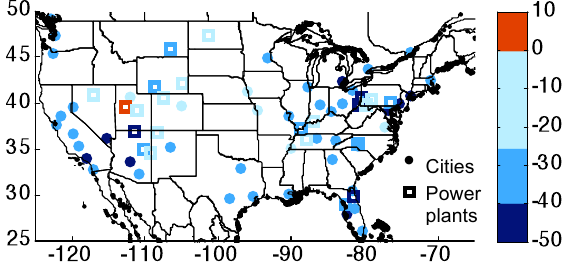
Fig. 3. Percent change in average summertime (April–September) OMI BEHR NO 2 column densities for 2005–2011 for major cities (dots) and power plants (squares). The medium blue color shows locations where reductions are within a standard deviation of the mean reduction for all cities, while the darker blue shows where reductions were larger, the light blue shows where reductions were smaller, and red shows regions where we observe increases in NO 2 for 2005–2011.